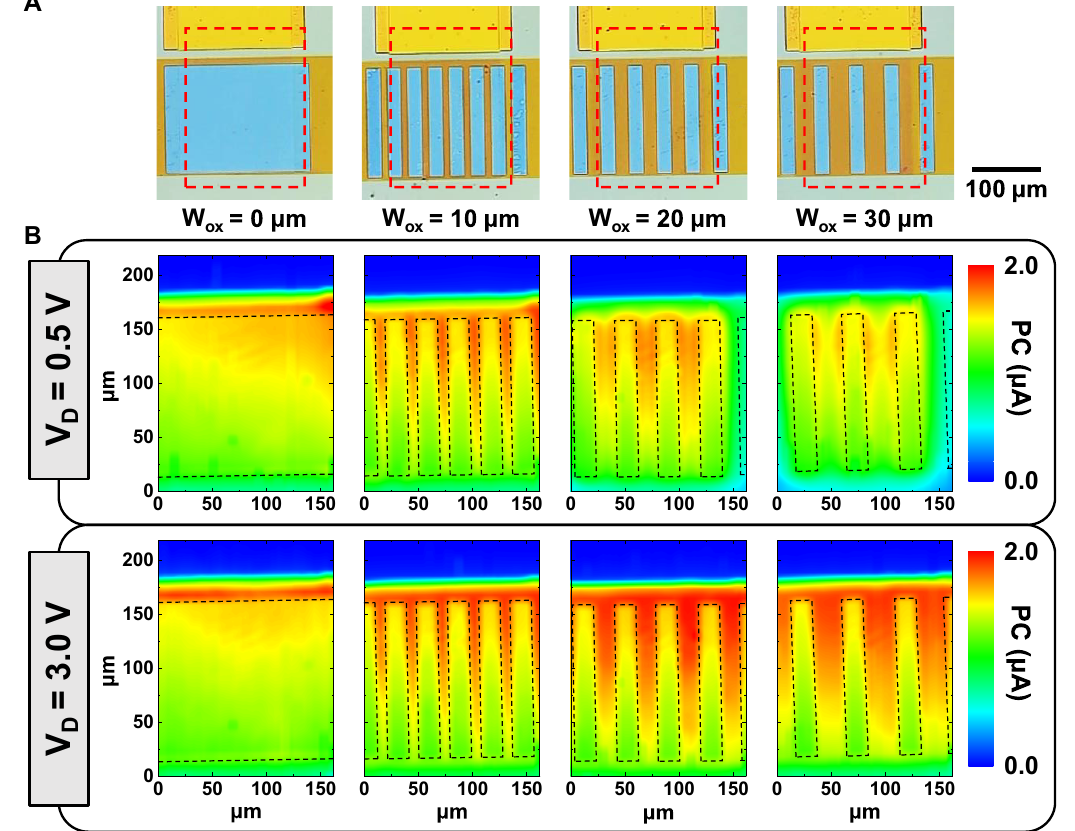
Figure 3: (A) Optical images of the photodetectors with various oxide widths ( W ox = 0, 10, 20, or 30 μ m). Red dashed line: area in which scanning photocurrent microscopy (SPCM) was measured. (B) SPCM images of the scanned area measured by a 1550 nm laser of 10 μ W. Photocurrent measured at V D = 0.5 V (above) and 3 V (below) under V G = − 10 V, respectively. Black dashed rectangle: graphene/Ge junctions. The scale of the photocurrents is the same for all